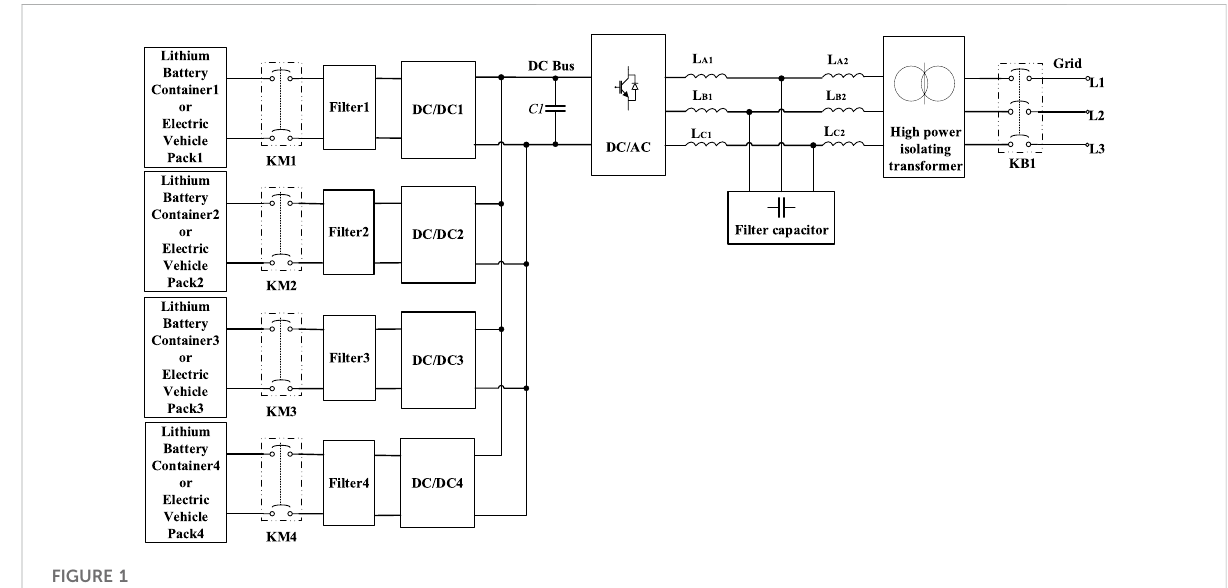
FIGURE 1 Two-stage topology with multiple DC modules for test